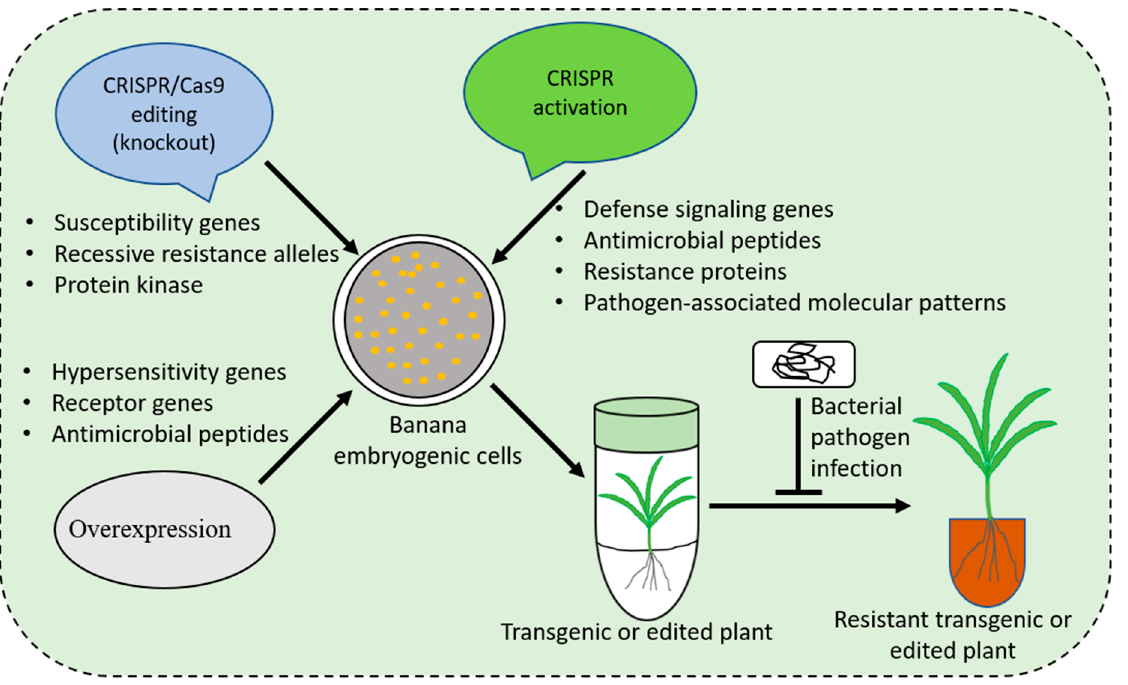
Figure 1. Schematic illustration of strategies for developing bacterial disease(s) resistant banana va- rieties.